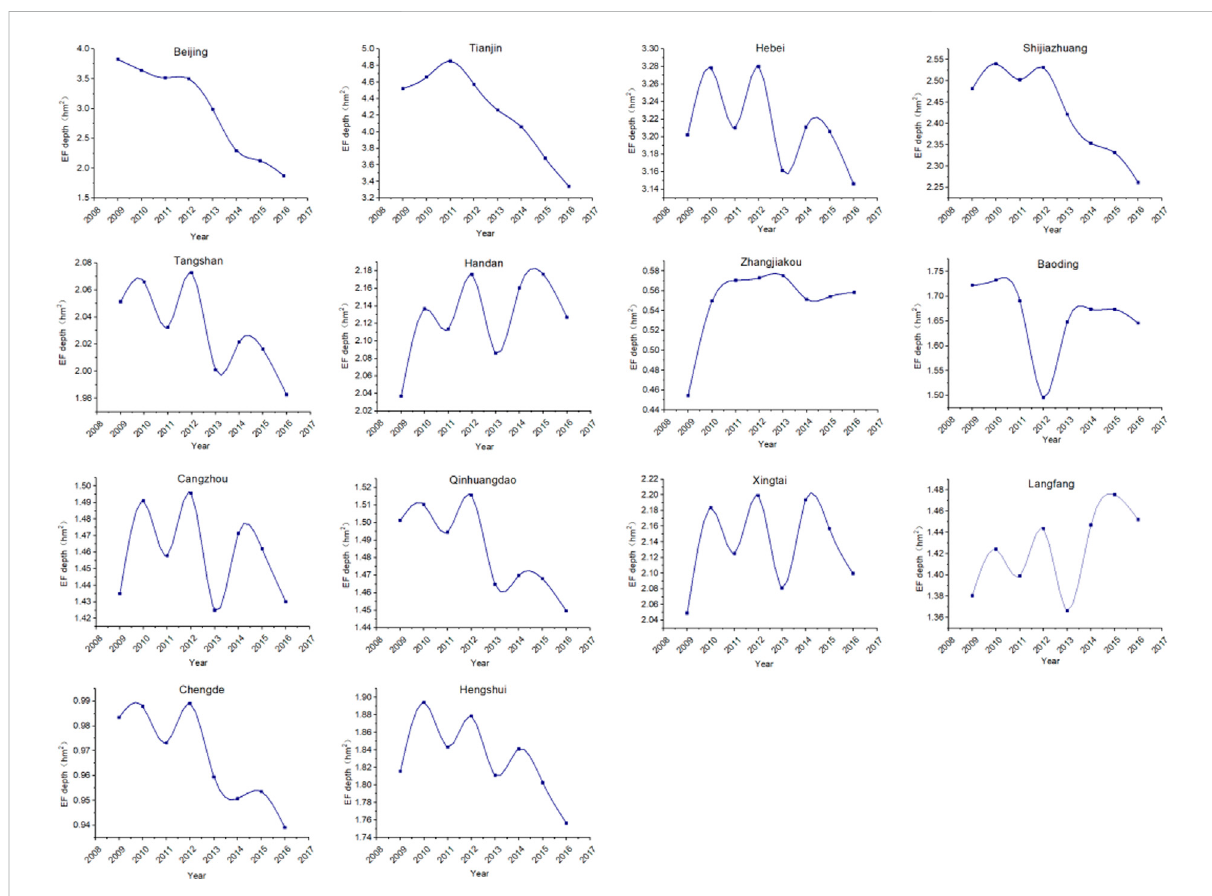
FIGURE 6 The trend of ecological footprint depth of cities in Beijing-Tianjin-Hebei region.